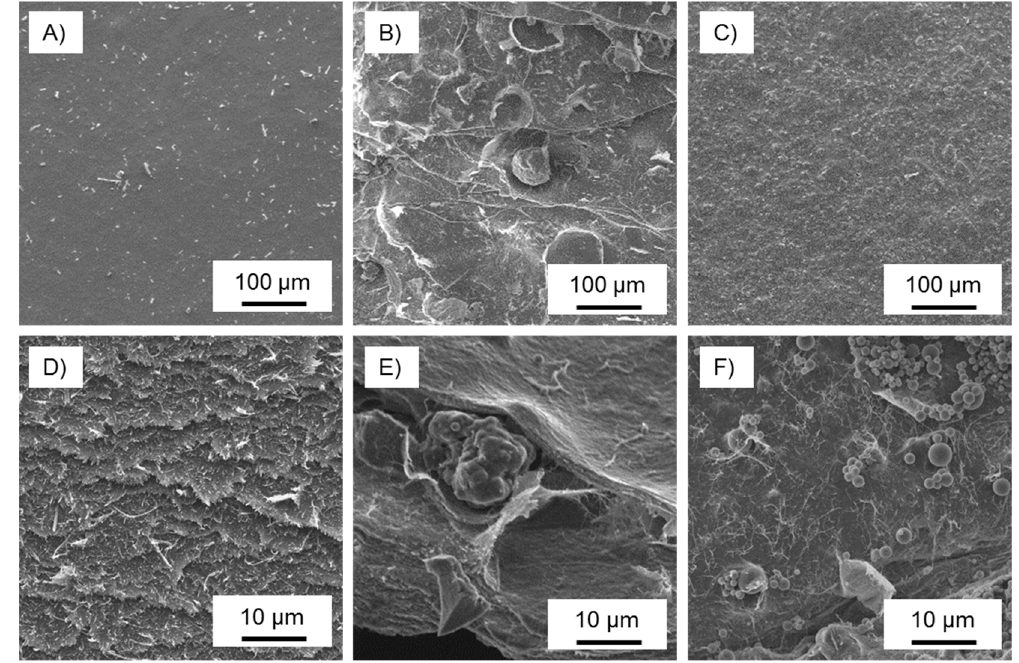
Figure 5. Scanning electron microscopy of the surface of pure cellulose nanopaper ( A ), nanopaper filled with 15 wt.% Indulin AT carbon ( B ), nanopaper filled with 15 wt.% sub-micron carbon ( C ), and corresponding fracture surfaces ( D – F ).